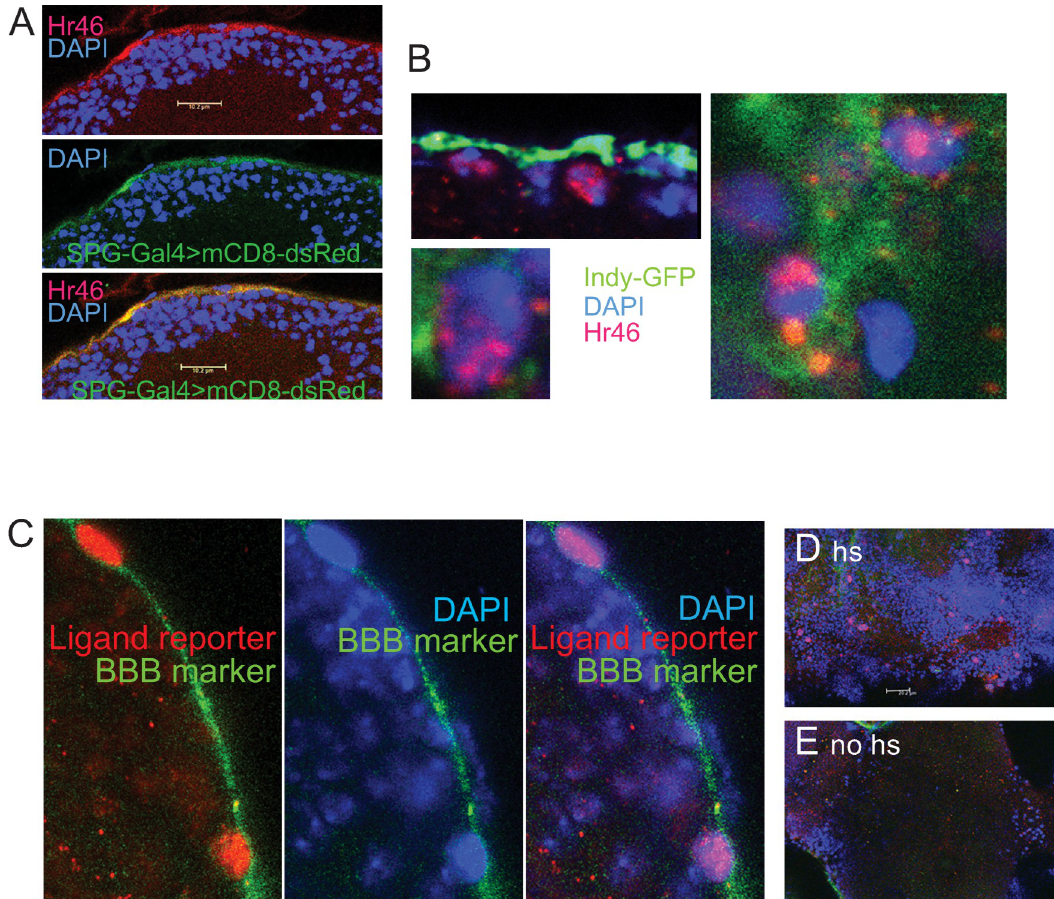
Fig 5. Hr46/Hr3 protein is located in SPG nuclei, and the Hr46/Hr3 ligand is present in the SPG cells of mature males. (A) Anti-Hr46 antibody staining (red) co-localizes with SPG-cell specific expression of dsRed in SPG-Gal4 (= moody-Gal4) > UAS-dsRed males (green). Blue: DNA staining (DAPI). Size bar: 10um. (B) Anti-Hr46 antibody staining (Red) shows the presence of Hr46 in the nuclei and cytoplasm of SPG cells. Indy-GFP (green) marks both PG and SPG cells. Blue: DNA staining (DAPI). 63x magnification. (C) Activation of the hs-Gal4 LBD HR3 reporter [25] indicates the presence of the Hr46/Hr3 ligand in SPG cells. hs- Gal4 LBD HR3 /UAS-dsRed/indy-GFP mature males were heat-shocked to express Gal4 LBD HR3 . Following binding of Hr3 ligand, Gal4 initiates transcription at UAS-dsRed(nuclear) . dsRed can be seen expressed in the characteristic large nuclei of SPG cells (red). Indy- GFP expression is used as a BBB marker (green). Blue: DNA staining (DAPI, blue). 63x magnification. (D) 40x magnification showing expression of dsRed in SPG nuclei following induction as described for C. Size bar = 20um. (E) No ds Red expression was observed in no-hs controls of the same genotype that were grown, treated, stained and imaged in an identical fashion.